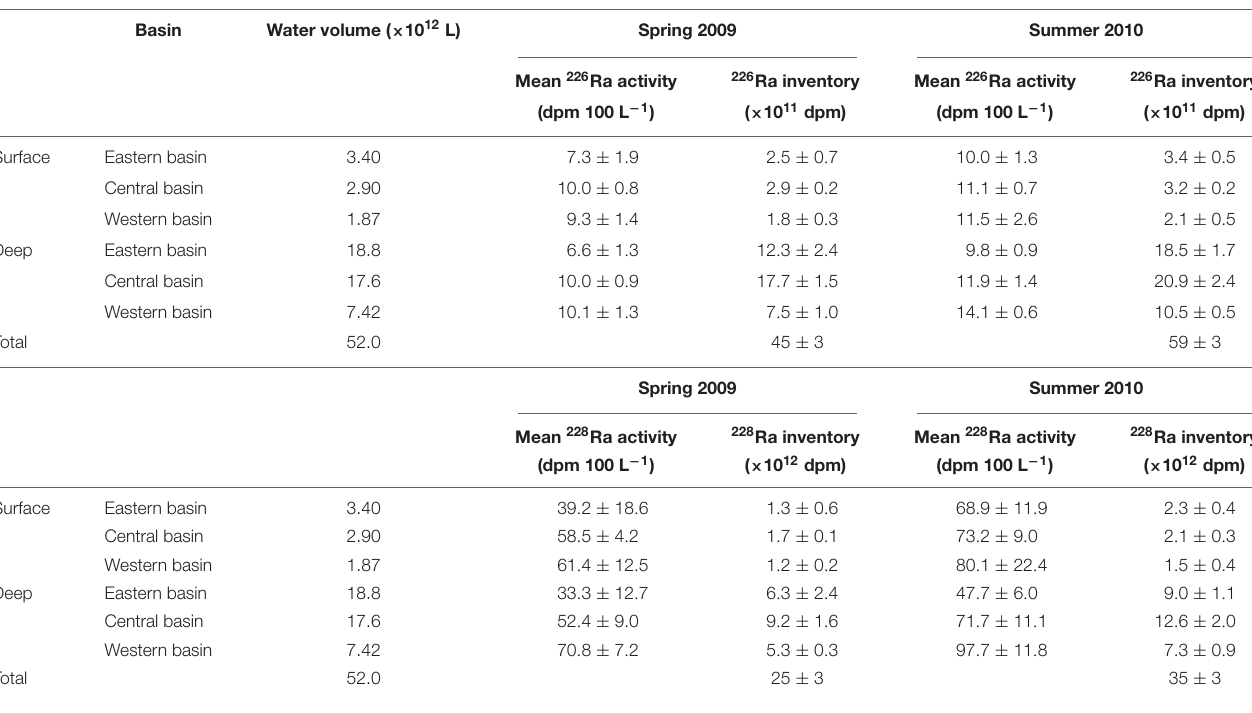
TABLE 4 | 226 Ra (top) and 228 Ra (bottom) inventories in western, central and eastern LIS in spring 2009 and summer 2010.